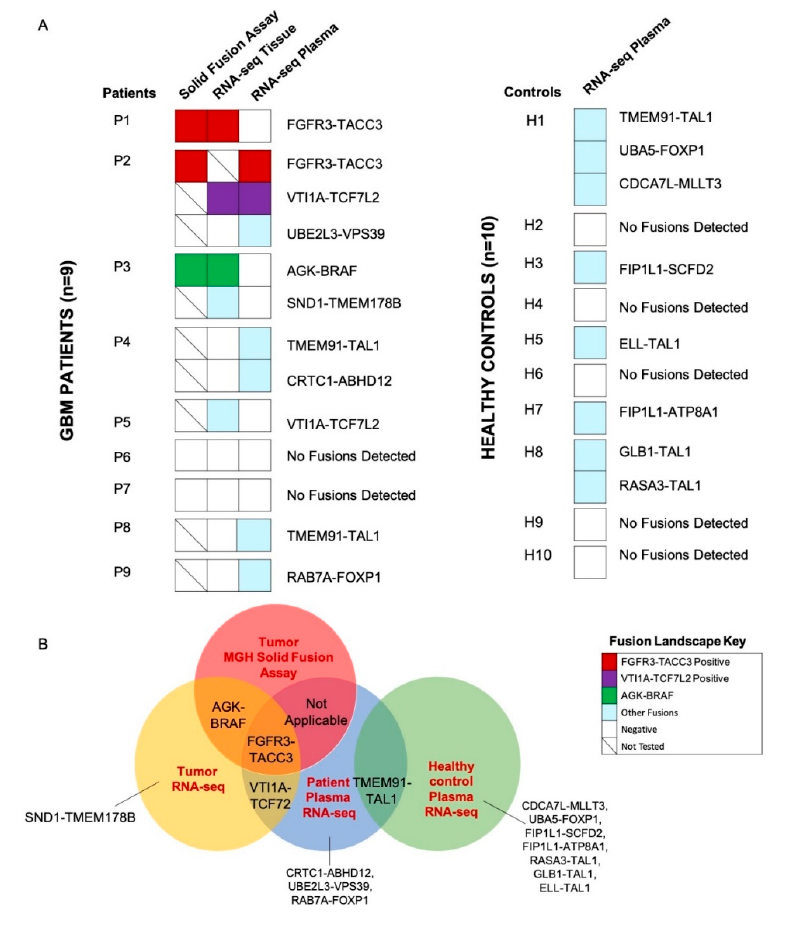
Figure 2. Tissue and plasma RNA fusion landscape. ( A ) Oncoprint depicting tumor tissue and plasma RNA fusions in the study cohort (GBM patients, n = 9, left; healthy controls, n = 10, right). ( B ) Summary of fusions detected by the Massachusetts General Hospital (MGH) Solid Fusion Assay of tumor tissue, RNA-seq of the tumor tissue and plasma of GBM patients and RNA-seq of the plasma of healthy controls.